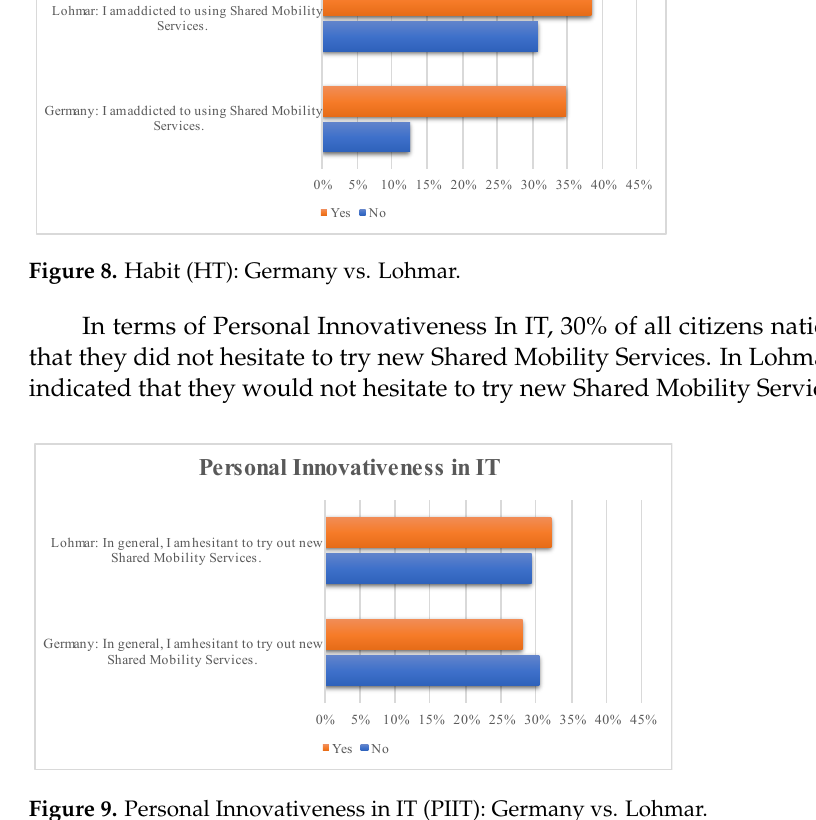
Figure 9. Personal Innovativeness in IT (PIIT): Germany vs. Lohmar.